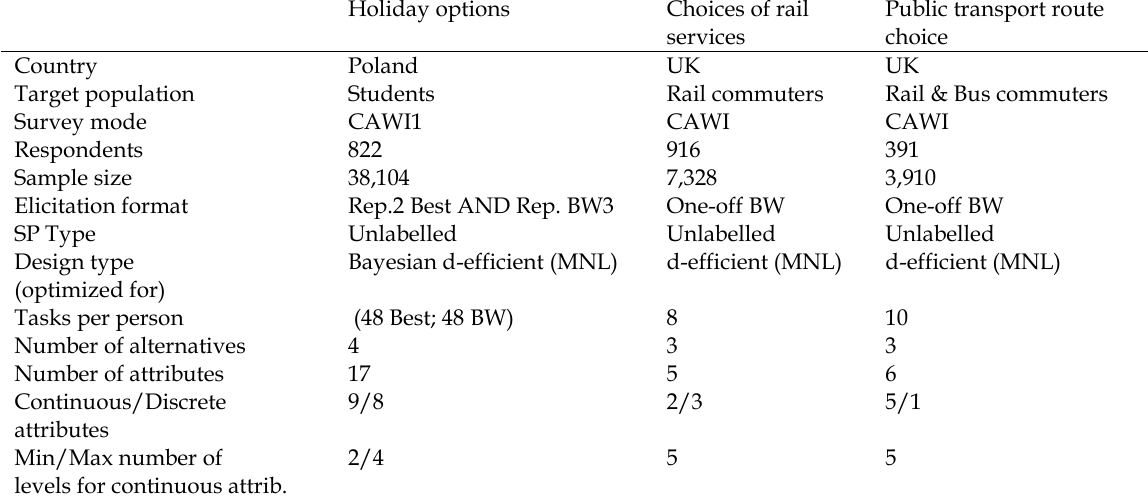
Table 2. Summary of